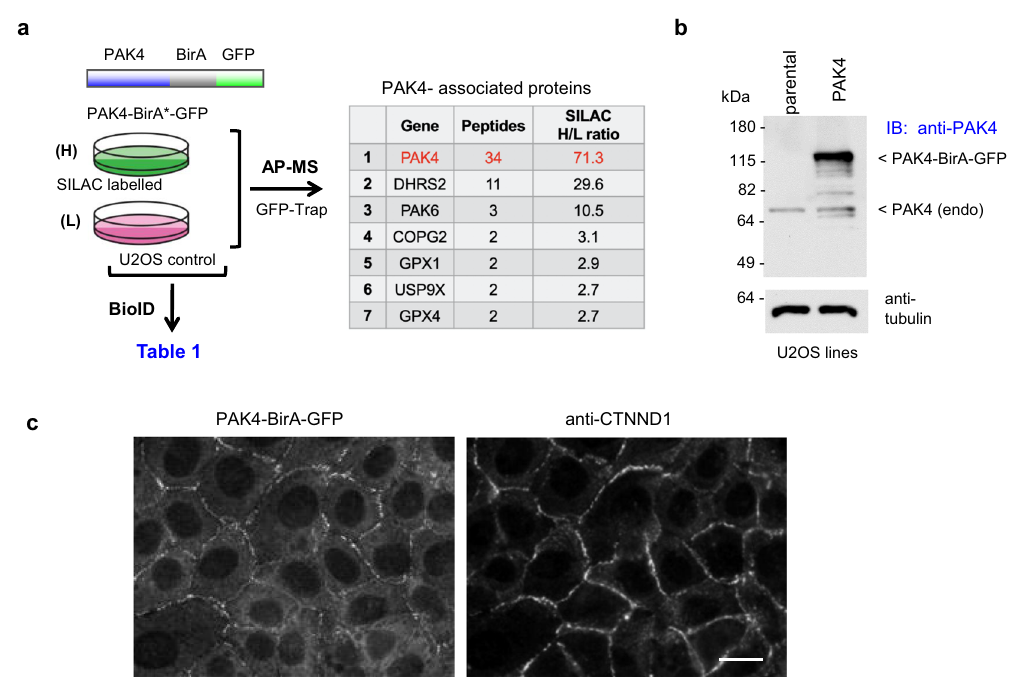
Fig. 1 Work fl ow of SILAC-enriched analysis of PAK4- proximal proteins. a Schematic of PAK4-BirA*GFP constructs used for SILAC BioID analysis. Summary of work fl ow used to identify PAK4-proximal proteins using stable cell lines cultured in either Arg/Lys isotopically heavy (H) or light (L) containing media as indicated. b Total lysate from control and PAK4-BirA*GFP cell lines were subjected to western blot to compare the expression of PAK4-BirA*GFP versus endogenous PAK4 (arrow) and repeated in two independent experiments. c Disposition of PAK4-BirA-GFP in stable U2OS cell lines. Cells were fi xed in PFA and immuno-stained for anti-GFP and anti-p120 ctn . Source data are provided as a Source Data fi